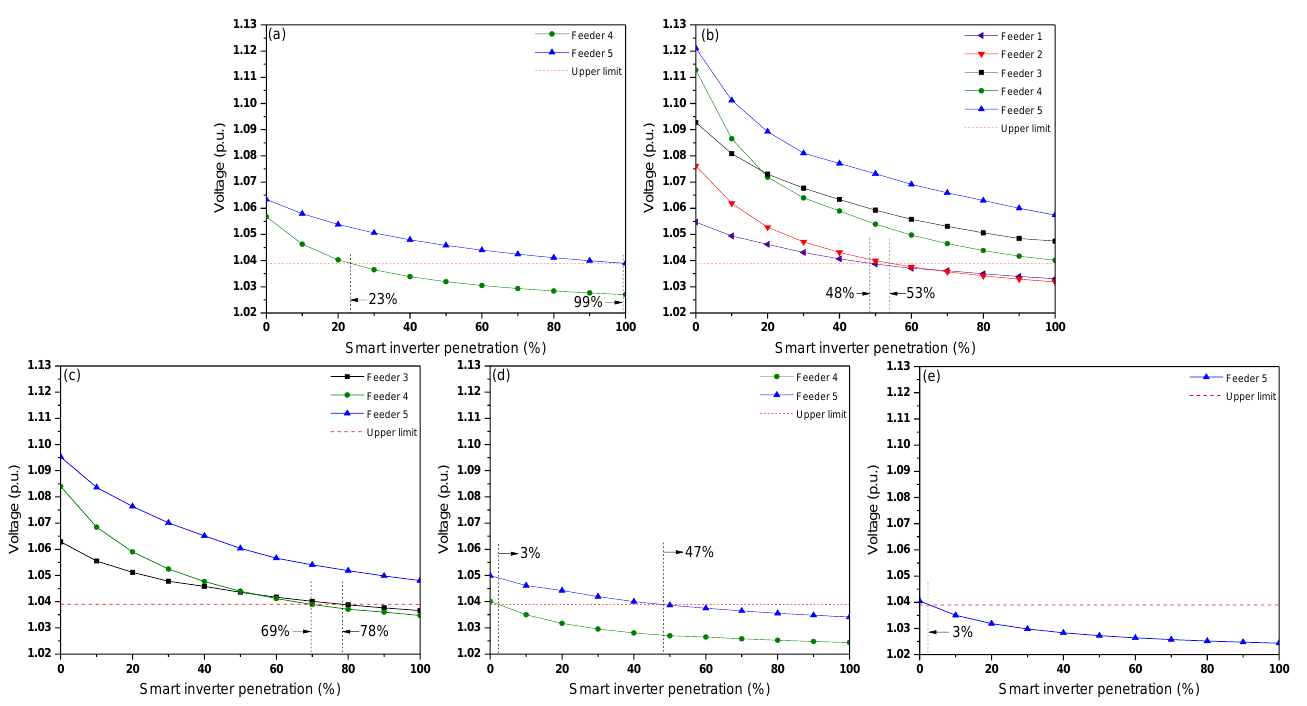
Figure 15. Maximum feeder voltages according to the penetration rate of smart inverters: ( a ) Case 1, ( b ) Case 3, ( c ) Case 4, ( d ) Case 5, and ( e ) Case 6. Table 5. Required compensation facilities and costs to solve the voltage